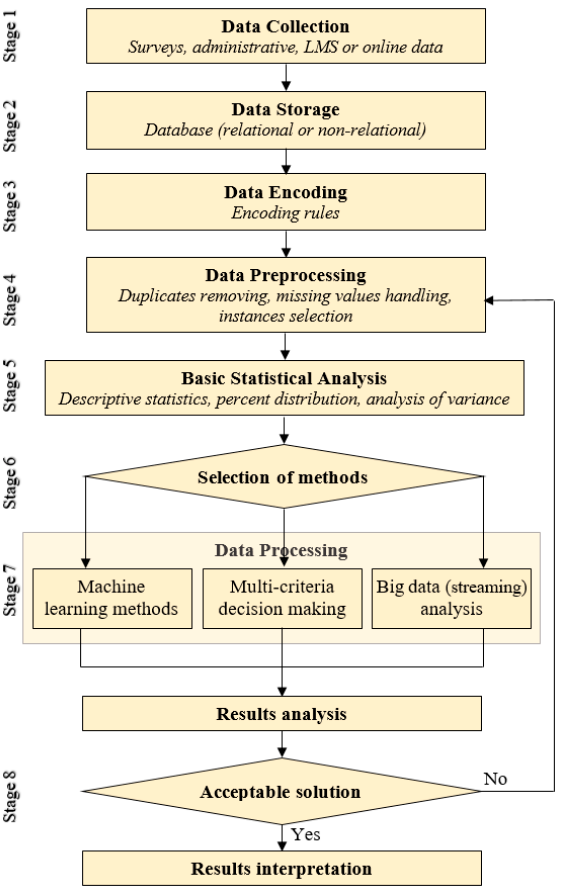
Figure 1. Framework for intelligent processing and analysis of educational data.